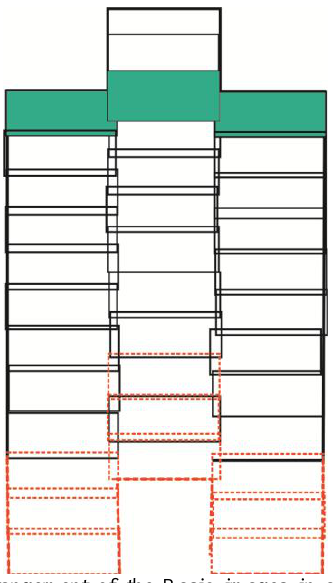
Figure 3: Arrangement of the Basic images in a data set for SkySat Collect, taken by SkySat SSC12